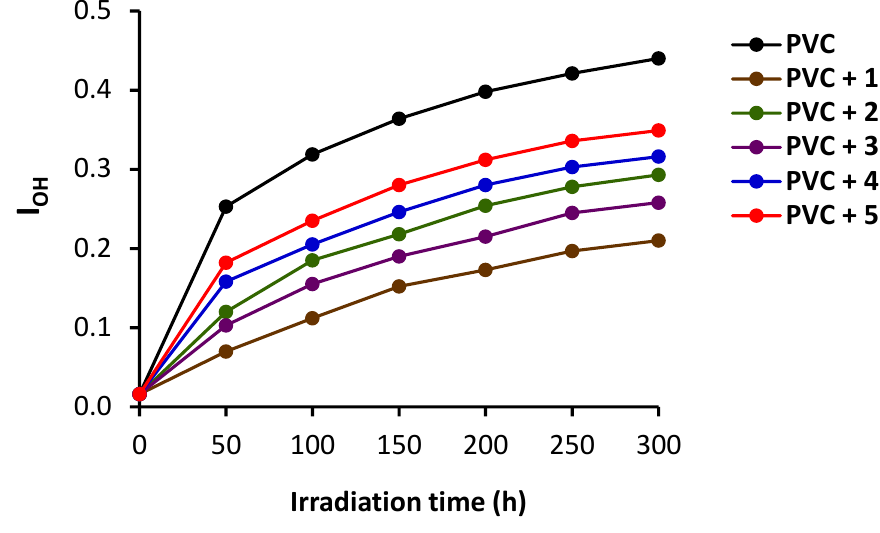
Figure 4. The I OH of the irradiated PVC films.